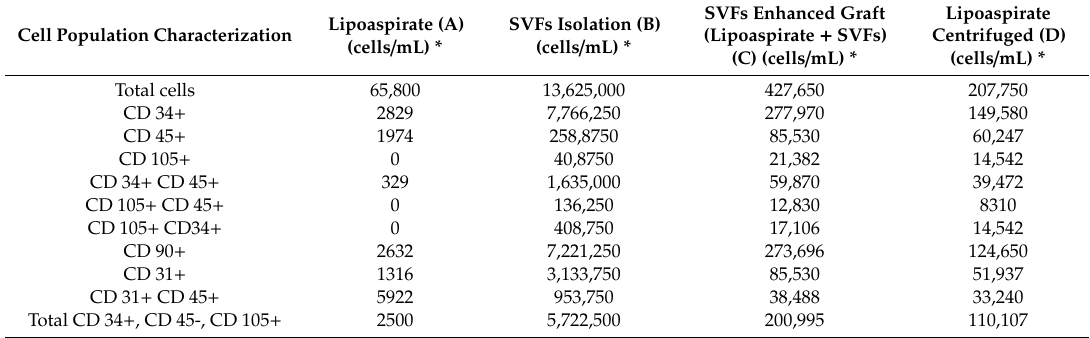
Table 2. Mesenchymal derived cell populations characterization in the adipose tissue graft